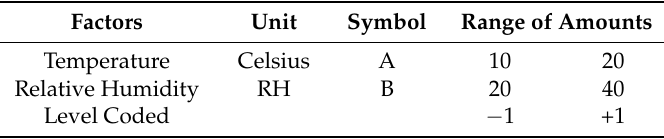
Table 3. Experimental range of amount and levels of the factors.